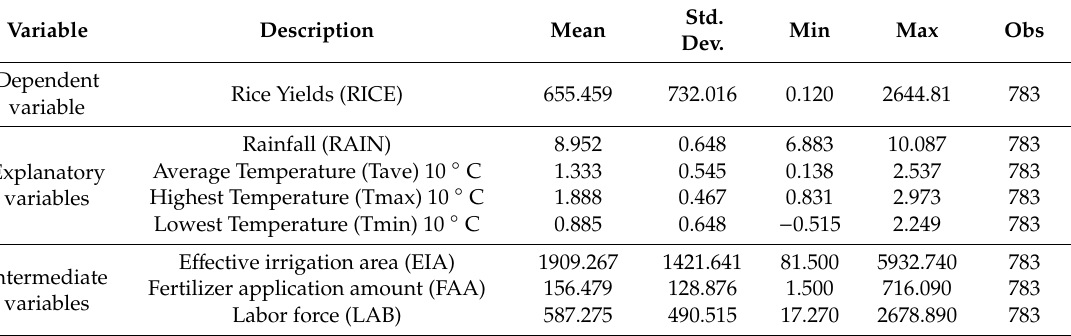
Table 1. Summary statistics of